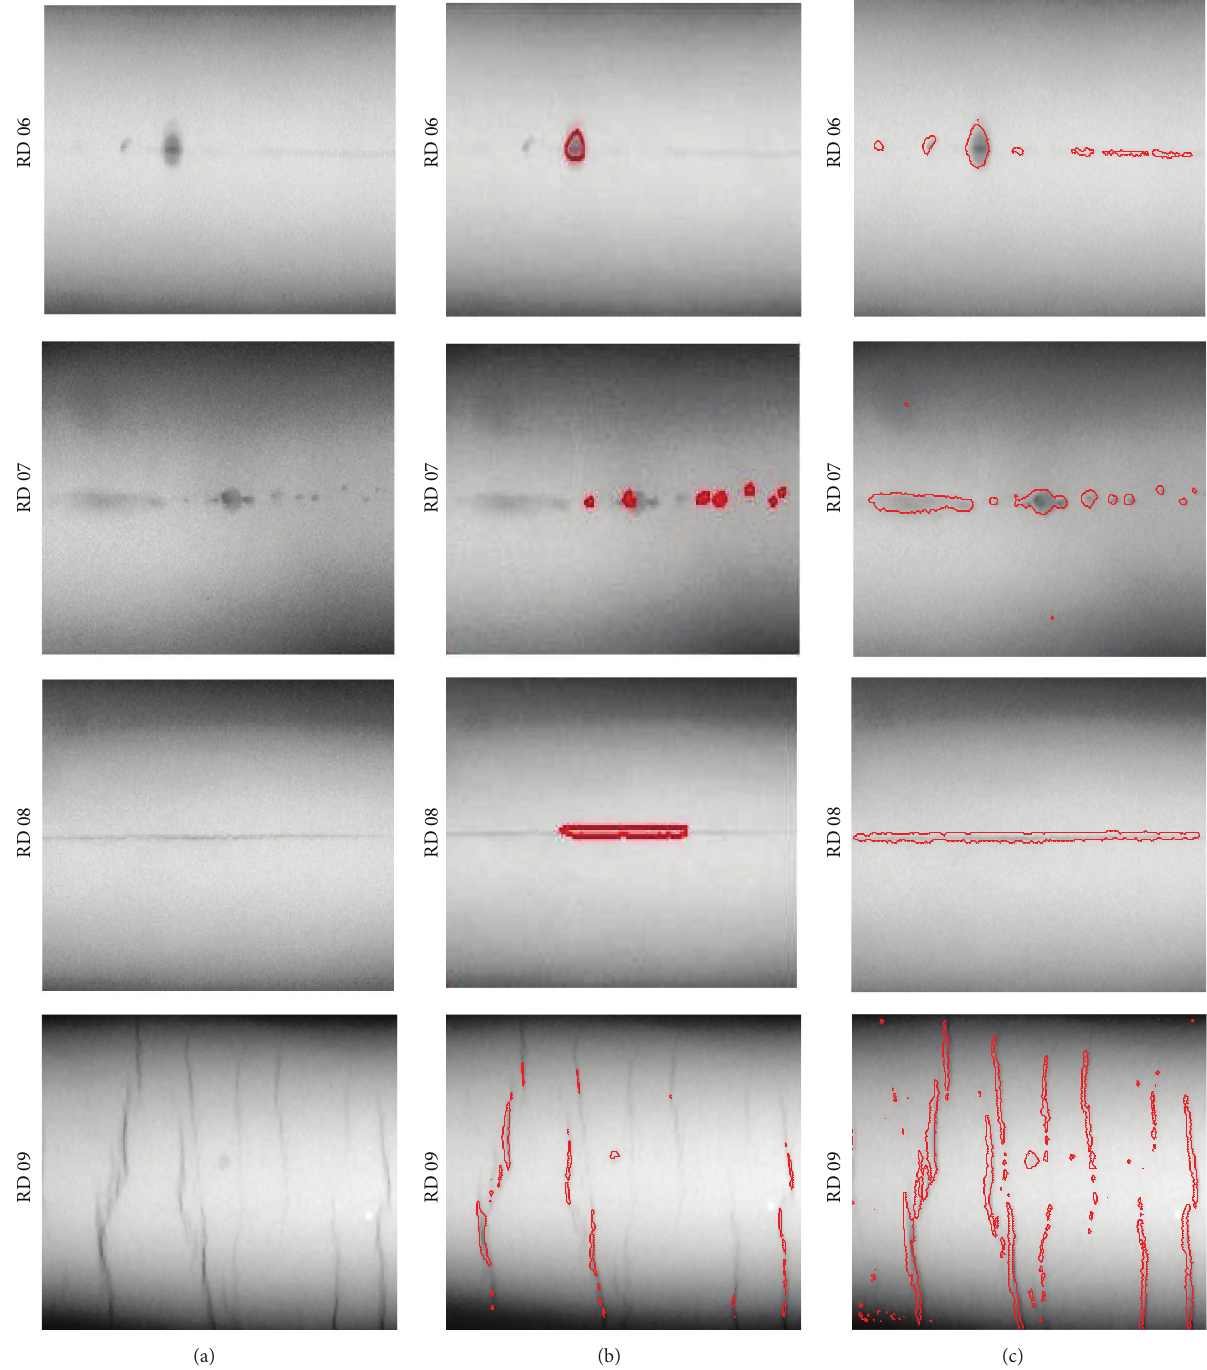
Figure 7: Comparative defect segmentation tests: (a) ROI selected image, (b) results of Song method, and (c) results of the proposed method.